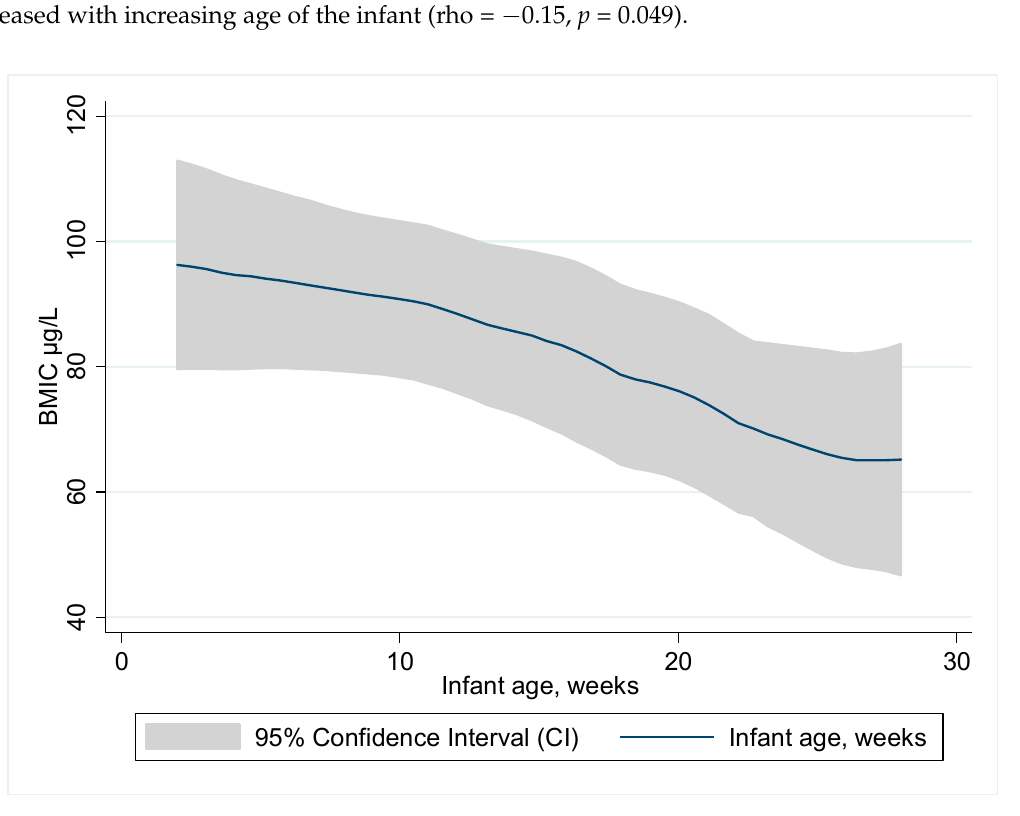
Figure 2. Association between breastmilk iodine concentration (BMIC) and age of the infant in weeks.